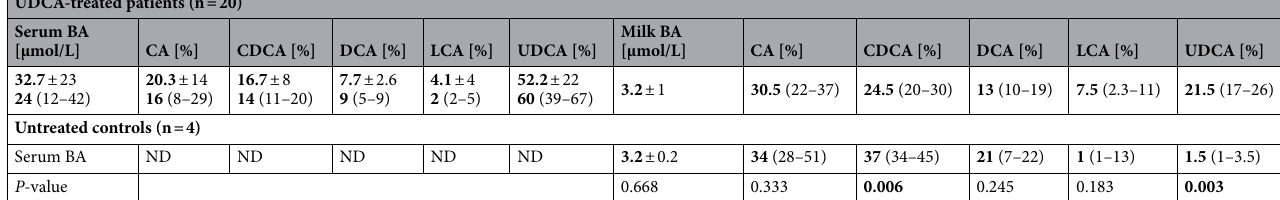
Table 1. BA concentrations in sera and human milk of breast-feeding women treated with UDCA. Data presented as mean ± SD and/or median and interquartile range. BA, bile acids; CA, cholic acid; CDCA, chenodeoxycholic acid; DCA, deoxycholic acid; LCA, lithocholic acid; UDCA, ursodeoxycholic acid; ND, not done. Significant values are in